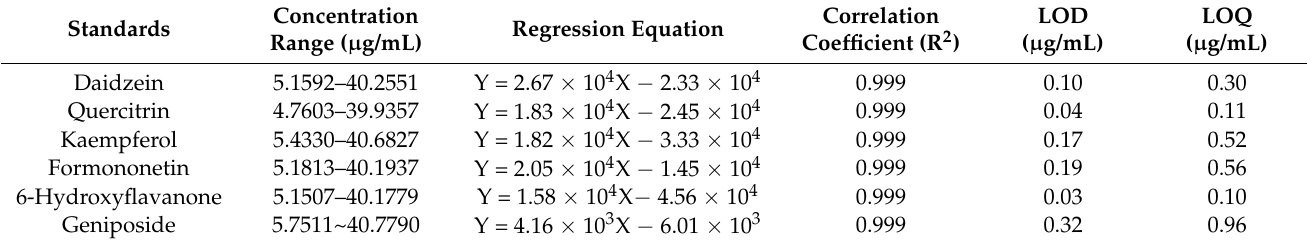
Table 4. Linearity, LOD, and LOQ values of the UHPLC method for the standard